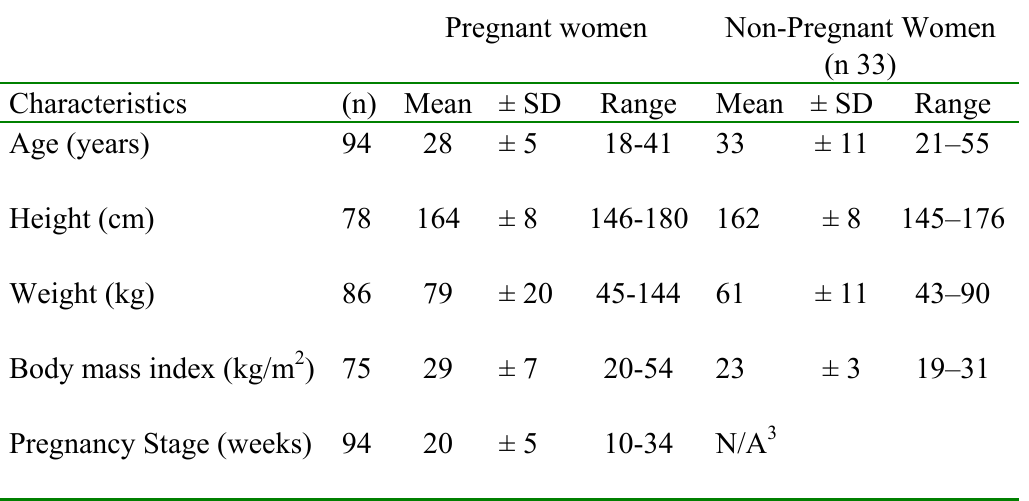
Table 1. Characteristics of pregnant and non-pregnant women study participants 1,2